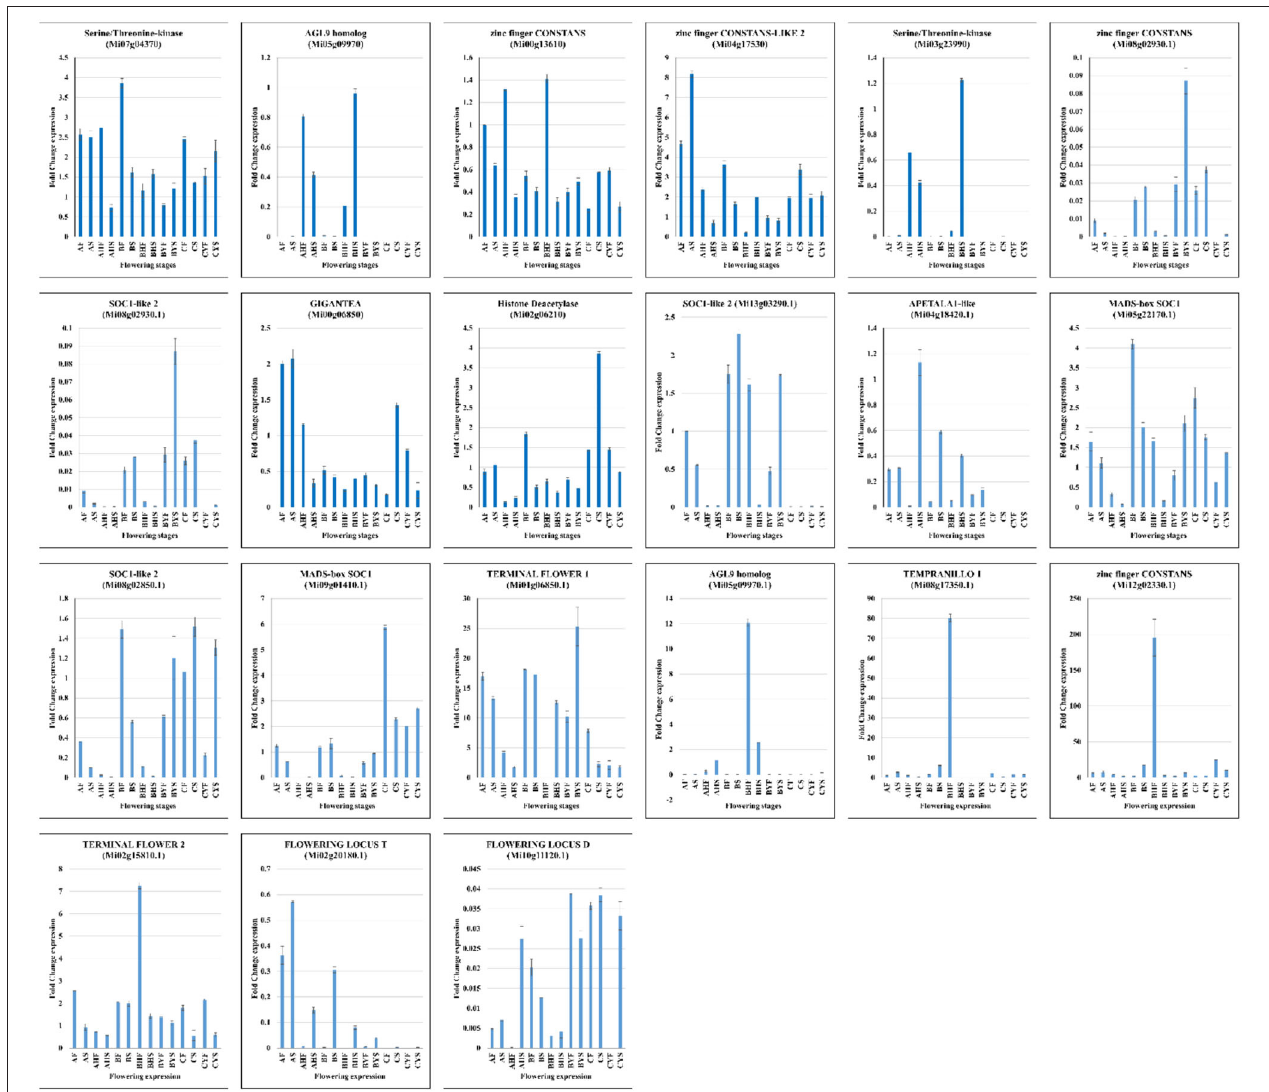
FIGURE 6 | The RT-qPCR analysis of 21 mango genes from AF, AHF, BF, BHF, BYF, CF, and CYF. The Actin gene was used as the internal control. The error bars show the standard